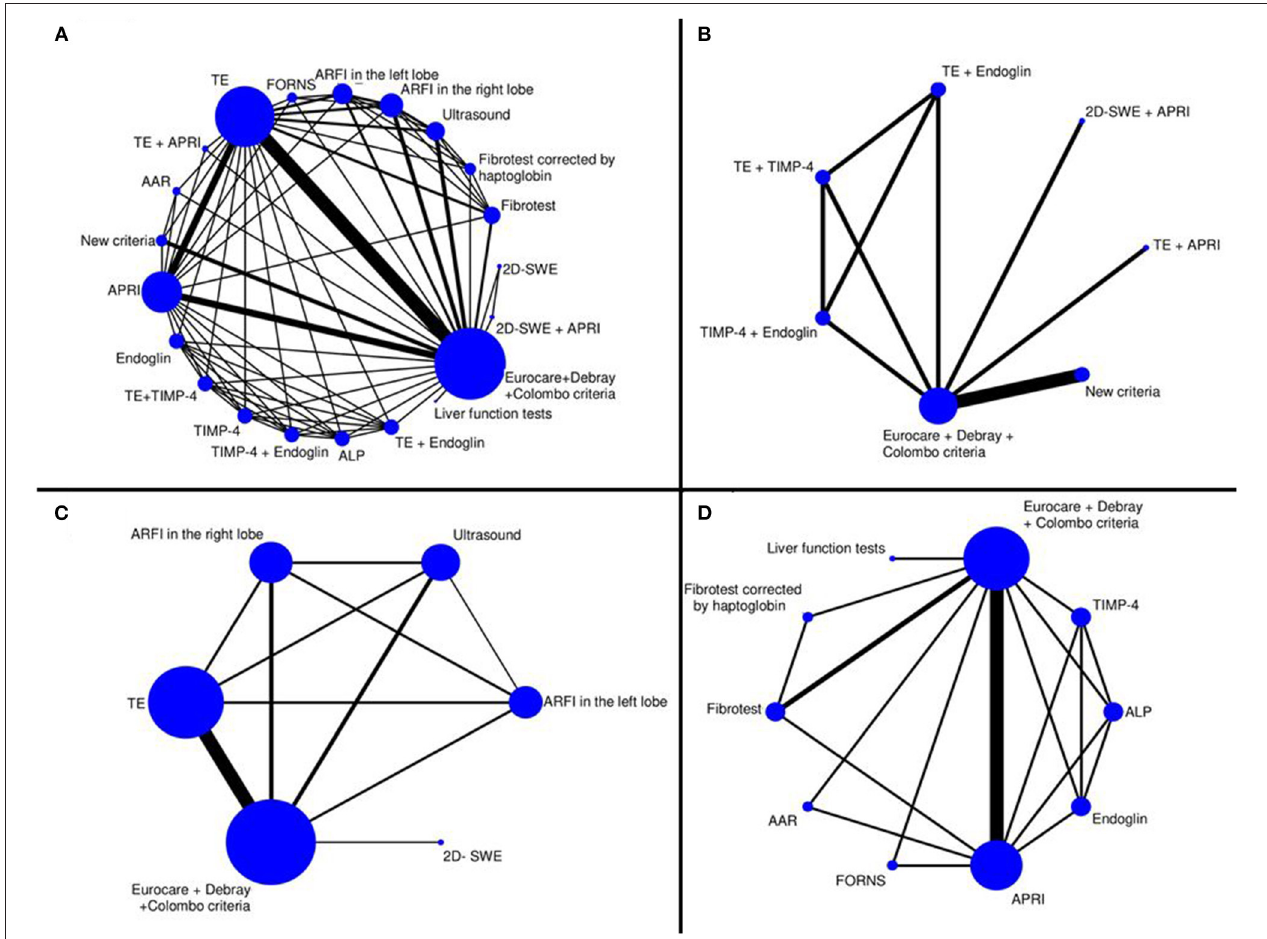
FIGURE 2 | Network graphs for the different diagnostic modalities. To display the created network we created, we designed graphs where nodes are associated with different non-invasive diagnostic techniques and edges (represented by solid black lines) serve as head-to-head (direct) comparisons. The size of the nodes is proportional to the number of studies evaluating each diagnostic test, and the thickness of the lines between the nodes is proportional to the number of each direct comparison. ( Network A) Comparison of all diagnostic tests ( n = 20) to the reference standard. ( Network B) Comparison of the combined tests and the New criteria to the reference standard ( n = 6). ( Network C) Comparison of tests based on imaging only ( n = 5). ( Network D) Comparison of biochemical markers and fibrosis indices ( n = 9) to the reference standard. TE, transient elastography; APRI, AST-to-platelet-ratio index; AAR, AST-to-ALT ratio; TIMP-4, tissue inhibitor of Metalloproteinase-4; ALP, alkaline phosphatase; Liver function tests; AST, aspartate aminotransferase; ALT, alanine aminotransferase; GGT, γ -glutamyl-transferase; 2D-SWE, two-dimensional shear wave elastography; ARFI, acoustic radiation force